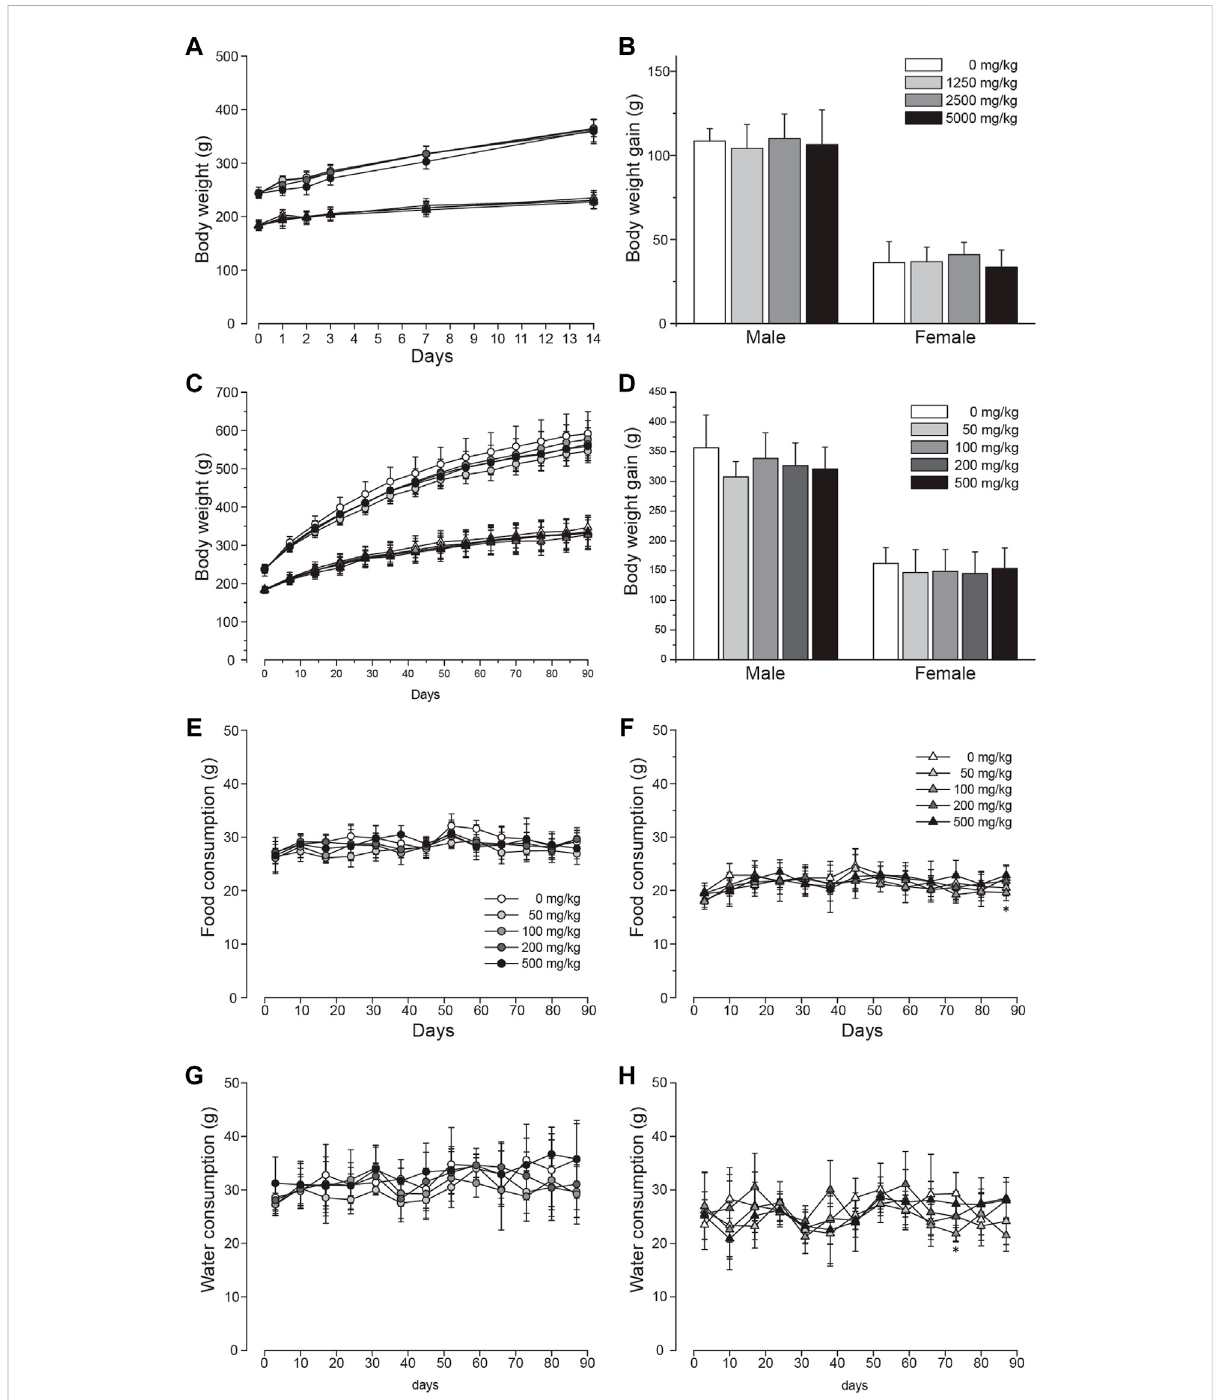
FIGURE 2 Unchanged body weight and food and water intake of SD rats orally administered with lac dye. Single oral administration of lac dye (LD) did not cause a recognizable change in (A) body weight and (B) body weight gain during the period of 14 days post administration. The animals orally administered LD for 90 days did not show differences in (C) body weight change and (D) body weight gain irrespective of treated doses. Circles are formaleandtrianglesforfemalegroupsin (A , C) withsymbolcolorsindicating thedoselevelsas describedin (B , D) ,respectively.Theconsumed amountoffood( E ;maleand F ;female)andwater( G ;maleand H ;female)wascomparableamongallofthegroupsduringthe90-daytestperiod.See the legends in (E , F) for the symbols used in (G , H) , respectively. * p < 0.05 by one-way ANOVA, followed by post hoc Dunnett ’ s t